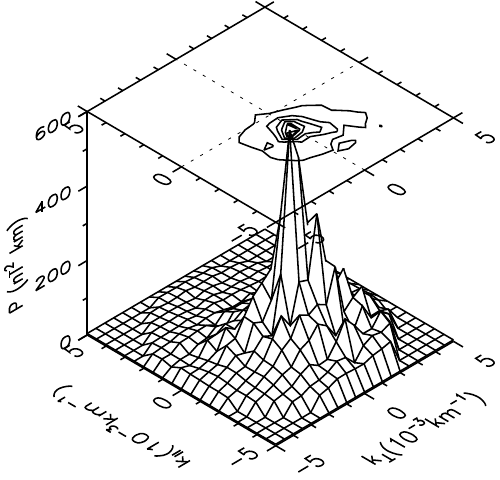
Fig. 4. Wave power in k -space made by the wave telescope and the magnetic field data from all four Cluster spacecraft for the same interval as Fig. 2. k ⊥ is in the same direction as ion bulk velocity projected into the perpendicular plane to the magnetic